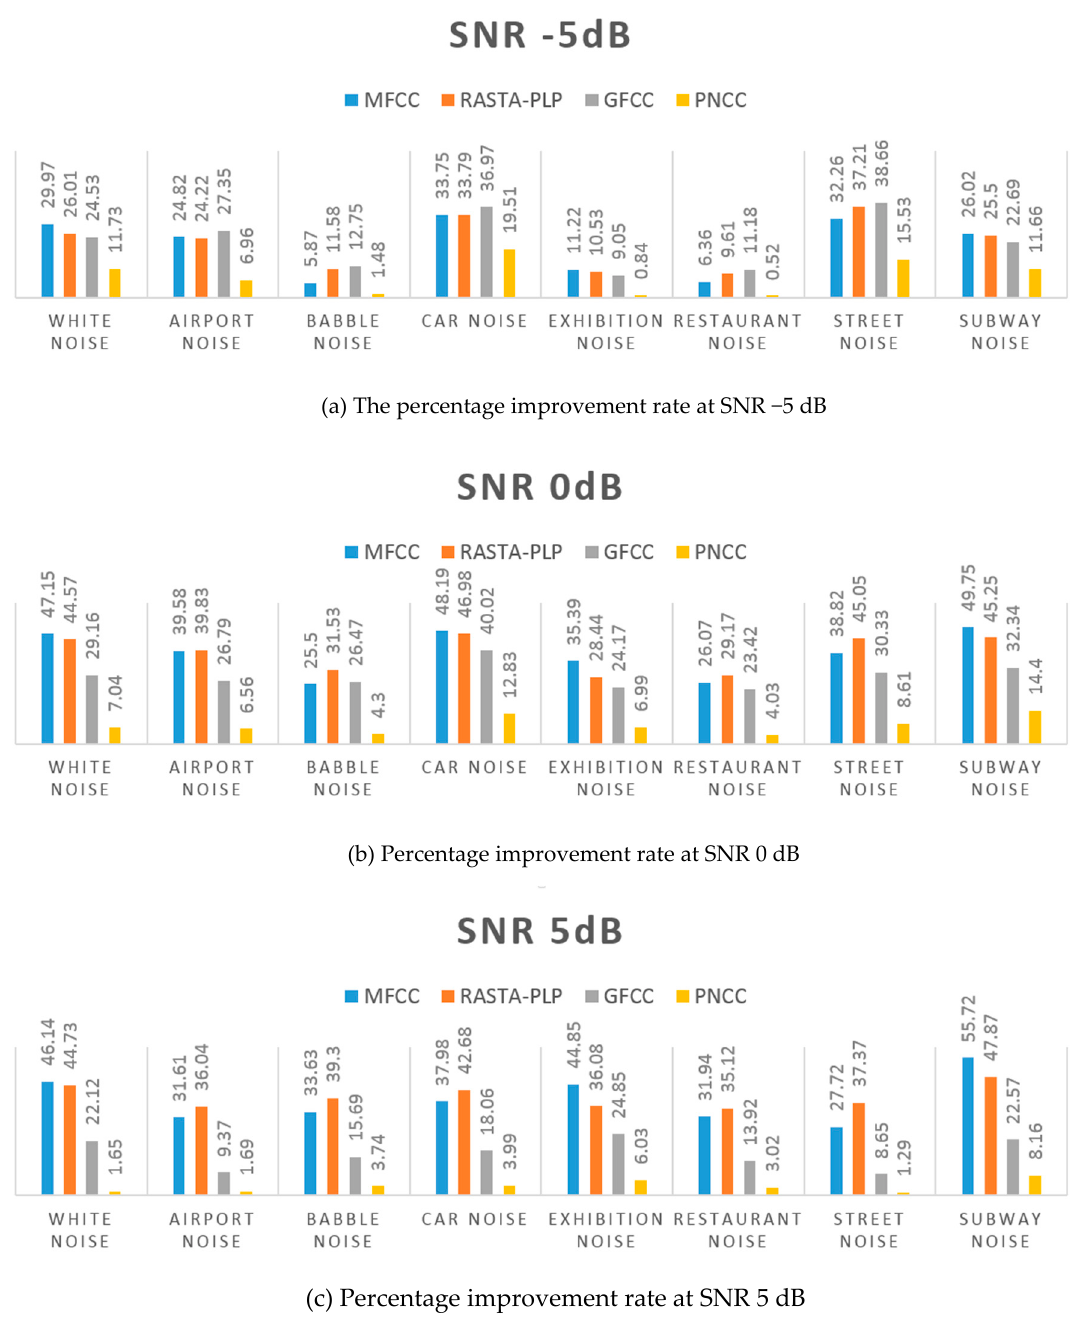
Figure 5. Percentage improvement rate of the proposed method for all noise types at SNRs − 5 dB, 0 dB, and 5